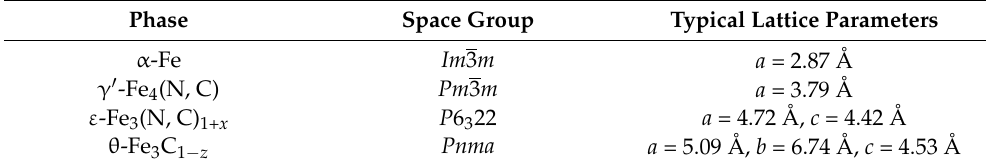
Table 2. Crystal structure data used for indexing of EBSD patterns and to evaluate XRD patterns. Phase Space Group Typical Lattice